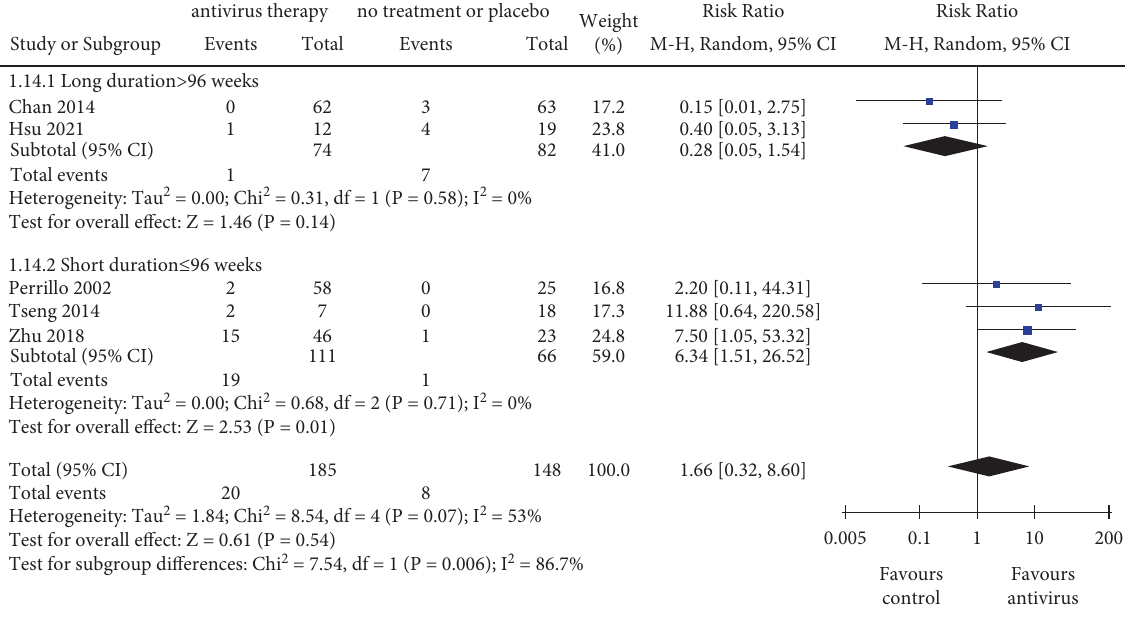
10 2001 Favours Favours control antivirus